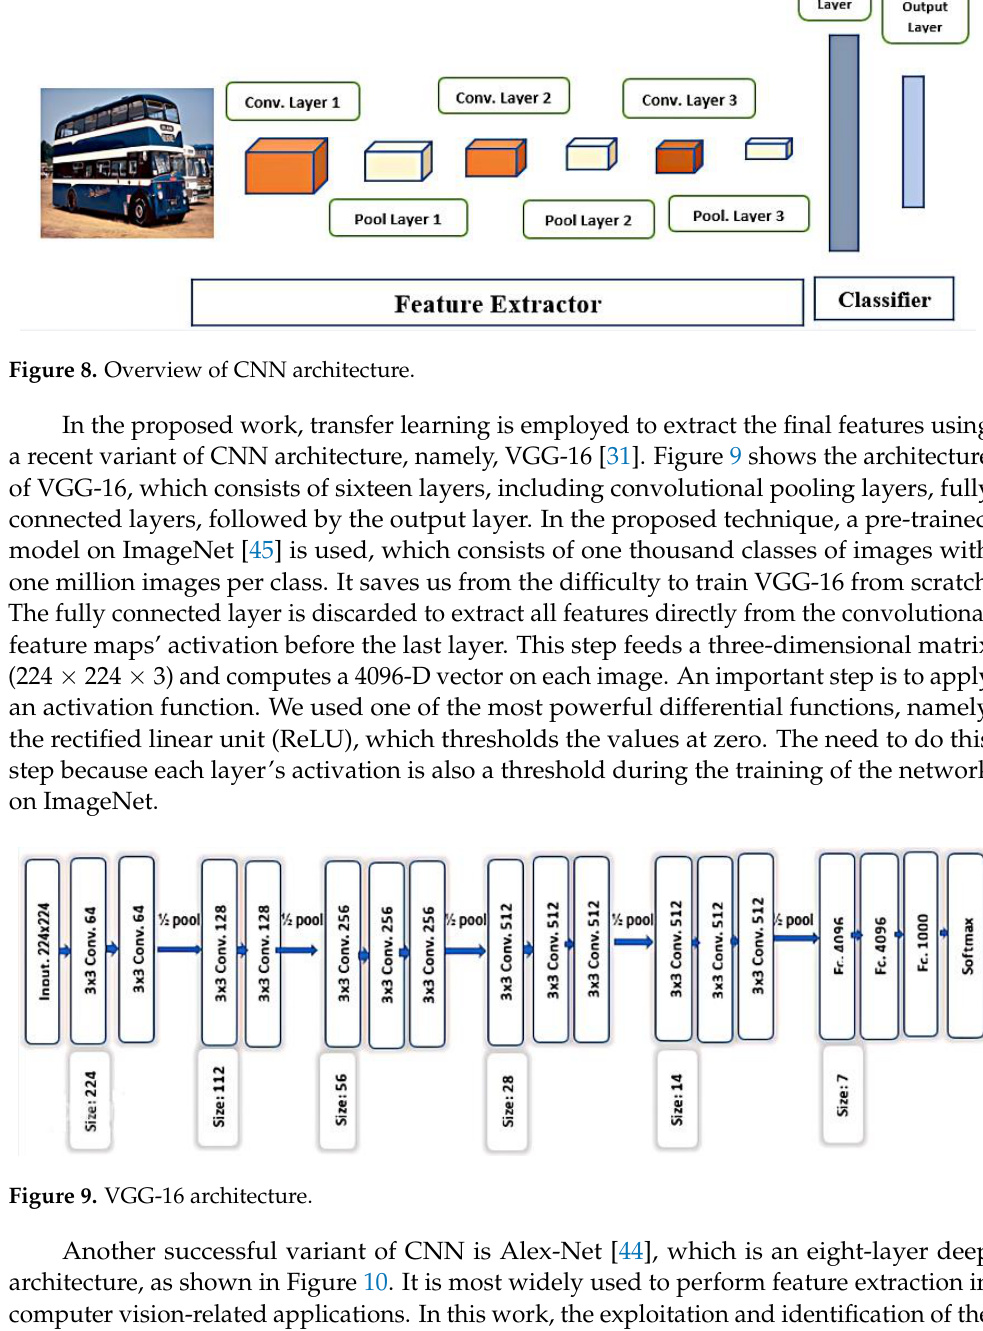
Figure 10. Alex-Net architecture.